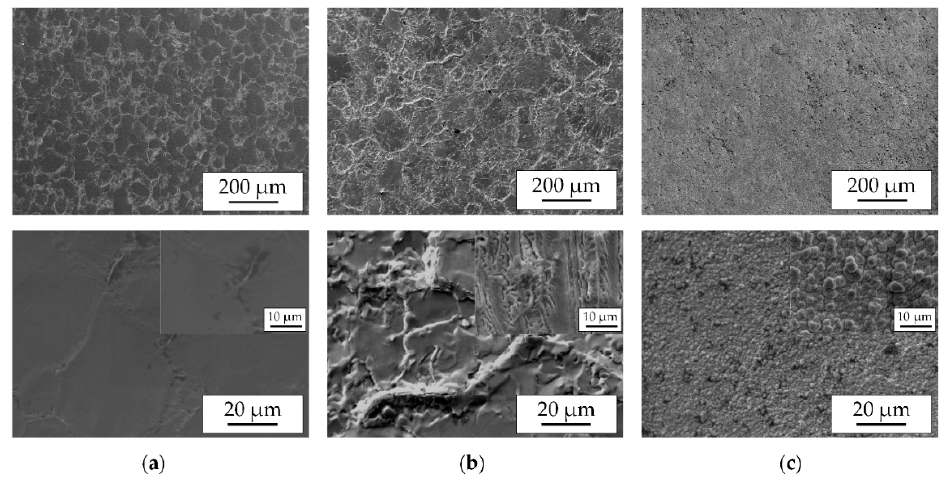
Figure 4. Surface topography of titanium Grade 2 after nitriding at temperatures of 750 °C ( a ) and 900 °C ( b ) and after boriding ( c ).